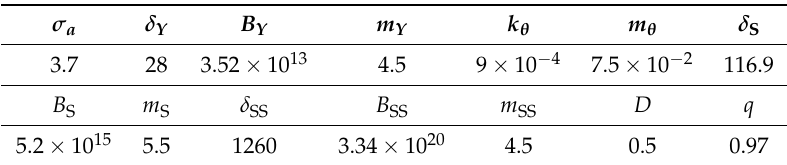
Table 1. Material parameter values